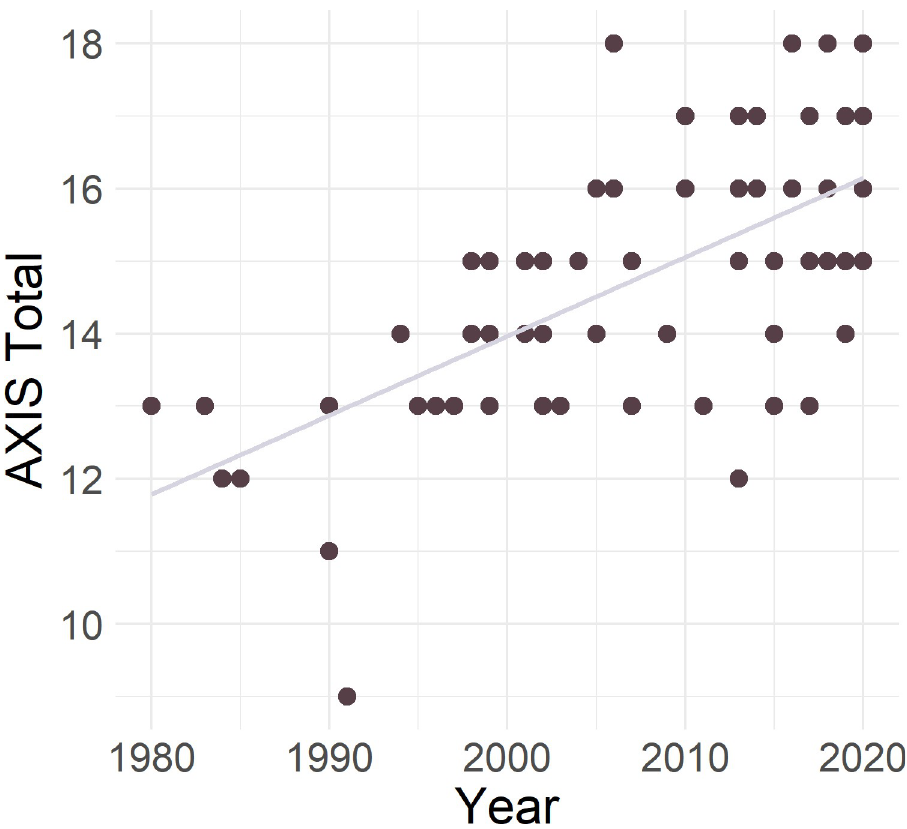
Fig 5. AXIS study quality (maximum = 20) by year of